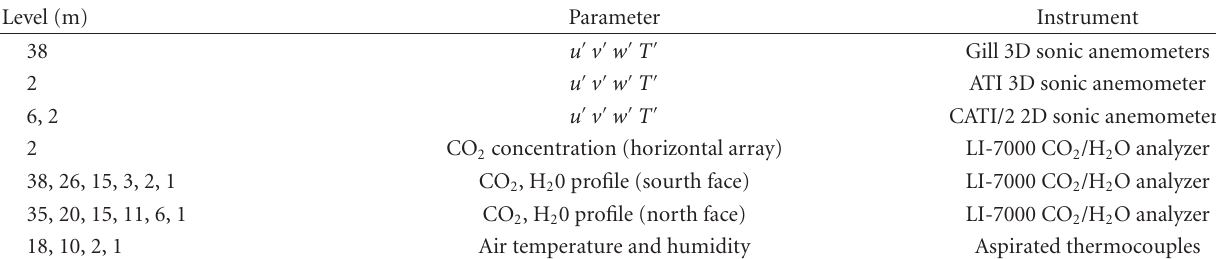
Table 1: DRAINO system sensors at ZF2 LBA Manaus site.